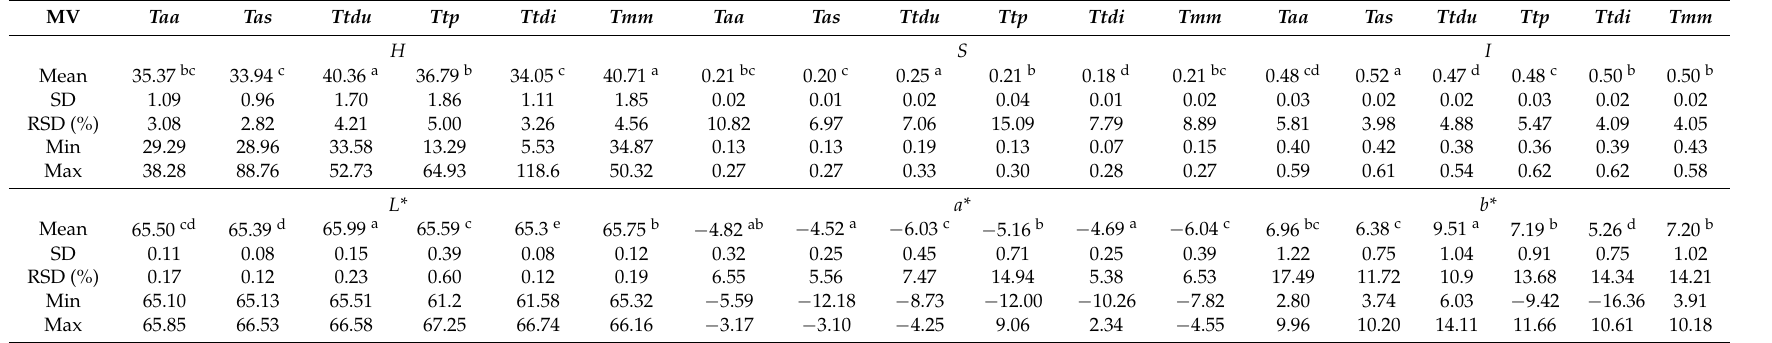
Table 4. The values of color descriptors taken into consideration in kernel image analysis of wheat